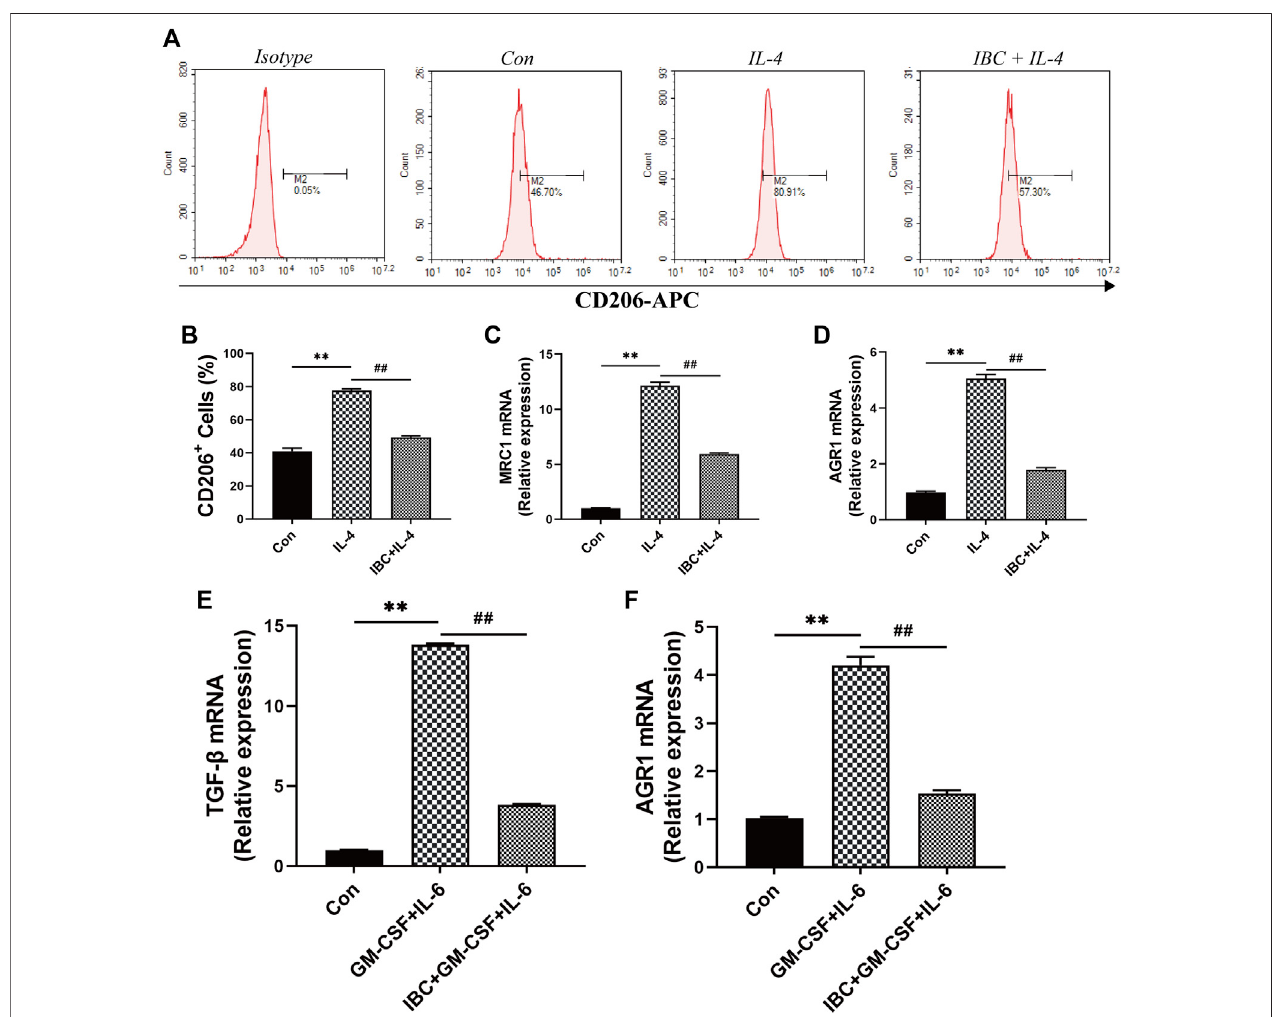
FIGURE 10 | The mechanism of IBC reduced the proportion of M2 macrophages. (A) RAW 264.7 macrophages were stimulated with IL-4 (20 ng/mL) and then treated with IBC (10 μ M) for 4h. (B-D) Comparison of CD206+ cells in the IL-4 + IBC group and the IL-4-stimulated group alone, IBC reduced the mRNA expression of ARG1 and MRC1 in M2 macrophages, ** p < 0.01 versus the control group and ## p < 0.01 versus the IL-4 group. (E,F) Comparison of MDSC in the GM-CSF + IL-6 groupandtheIBC+GM-CSF+IL-6group,IBCreducedthemRNAexpressionofTGF- β andAGR1,** p < 0.01versusthecontrolgroupand## p < 0.01versusthe GM-CSF + IL-6